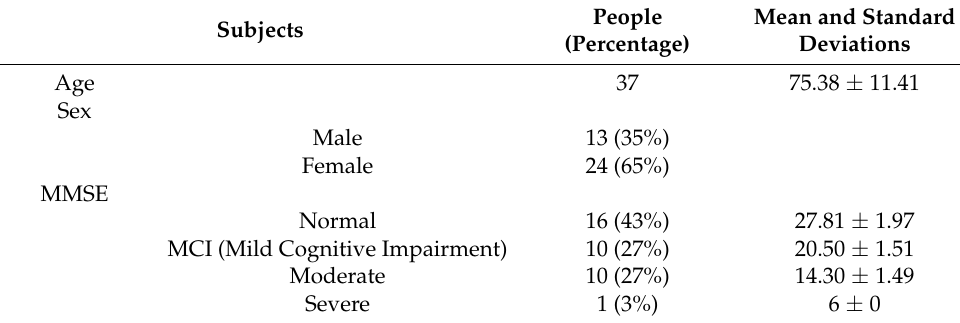
Table 3. Demographic of the subjects with the clinical questionnaire MMSE (Mini Mental State Examination)